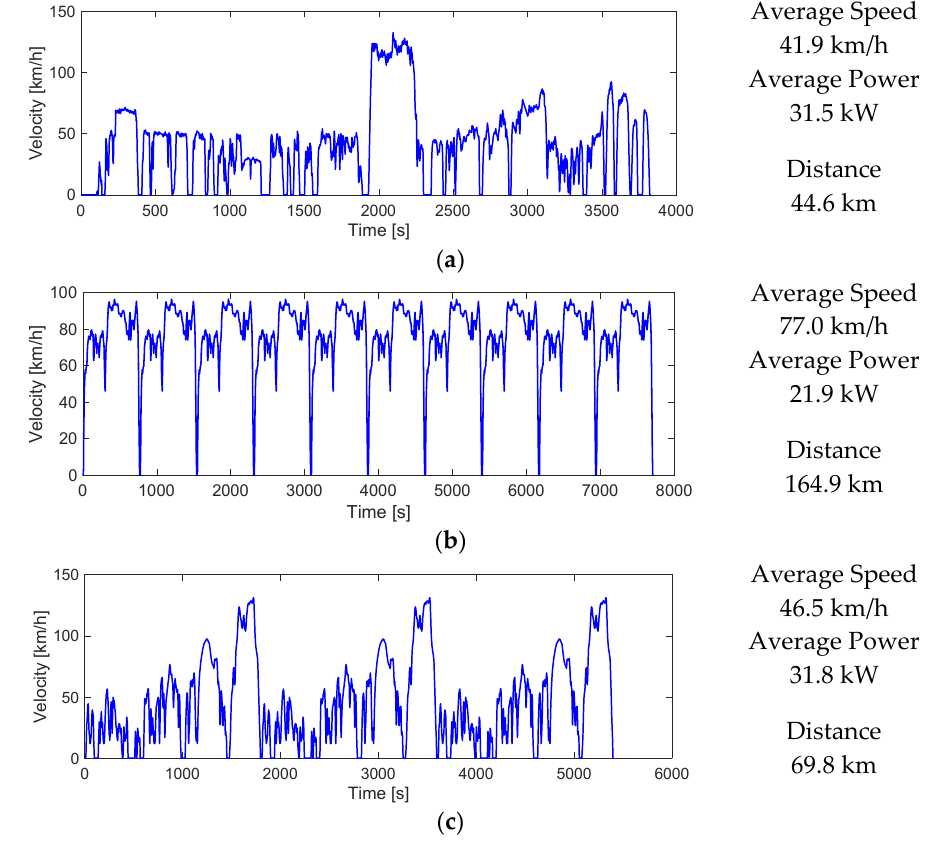
Figure 13. Test driving cycles: ( a ) Aachen; ( b ) FHDS × 10; ( c ) WLTC × 3. The cycle repetitions are needed to obtain the same cooling circuit operating time and realistic trip length. Also, to add variability to the road power demand, each cycle repeti- tion is characterized by a different road grade profile.